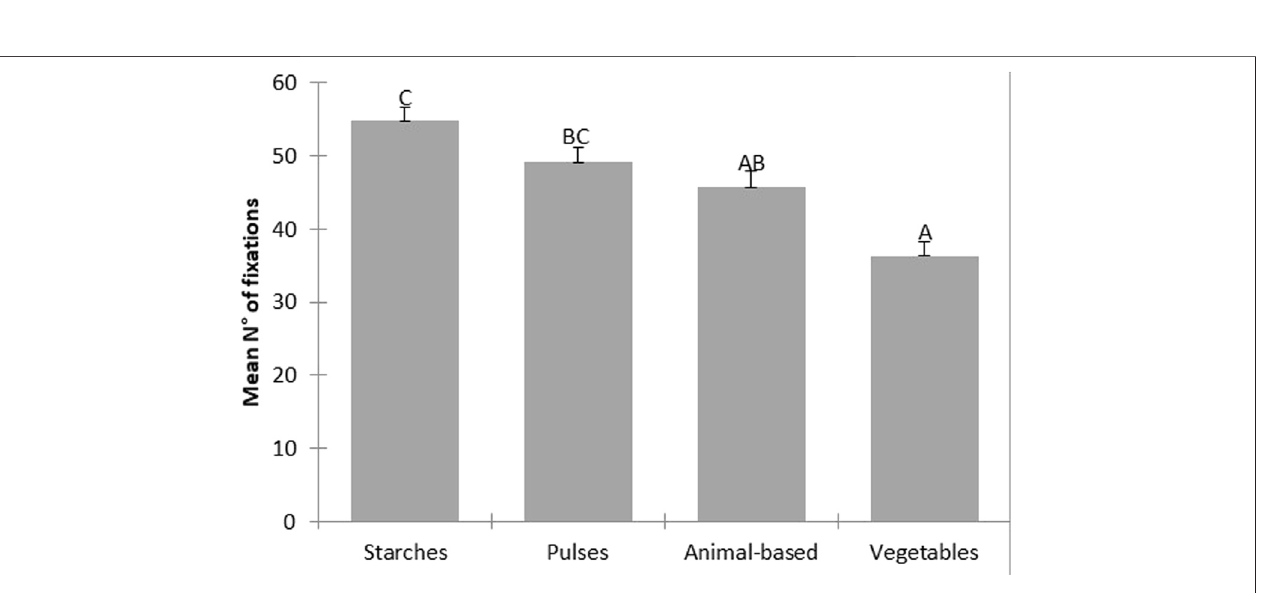
Frontiers in Virtual Reality |